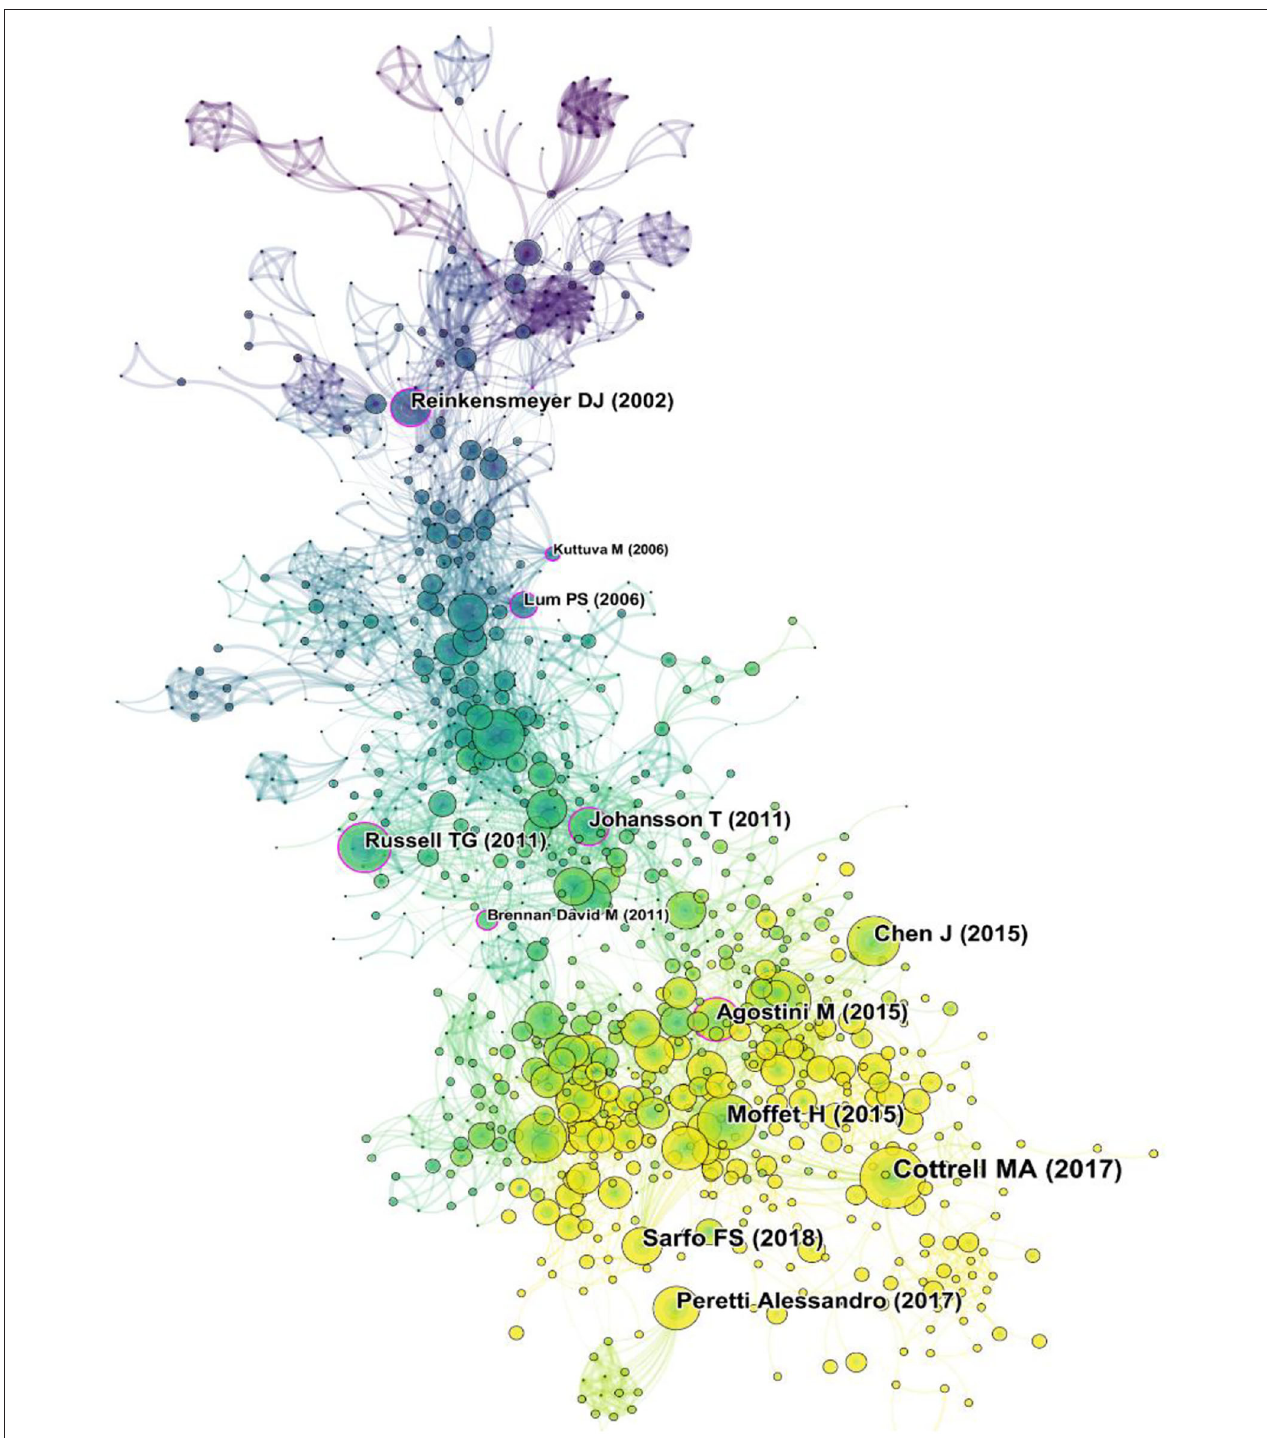
FIGURE 7 | Map of cited references to telerehabilitation from 2000 to 2021.